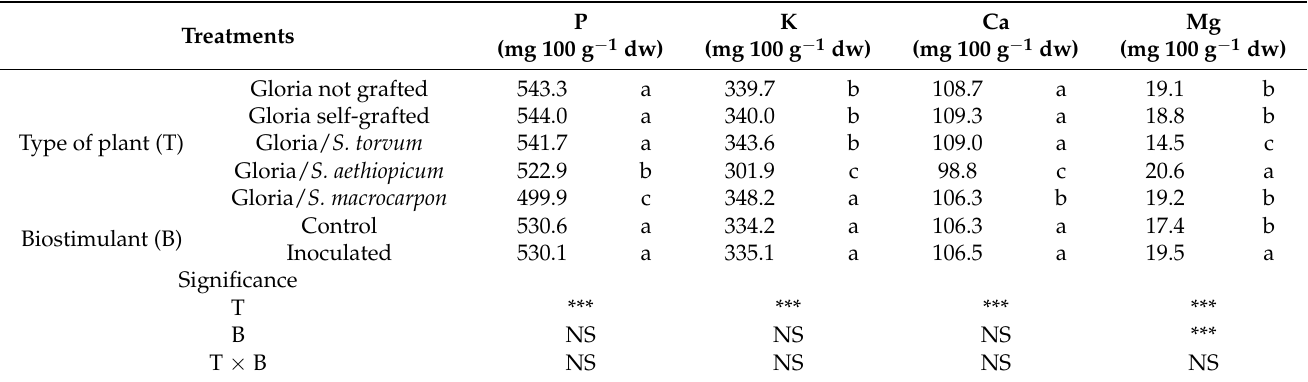
Table 3. Influences of the type of plant and biostimulant application on the mineral profile (phospho- rous, potassium, calcium and magnesium) of eggplant